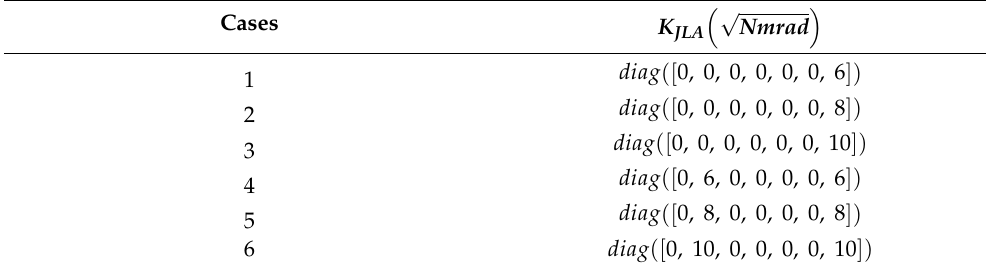
Table 2. Different weighting matrix choices for classical joint-limit avoidance